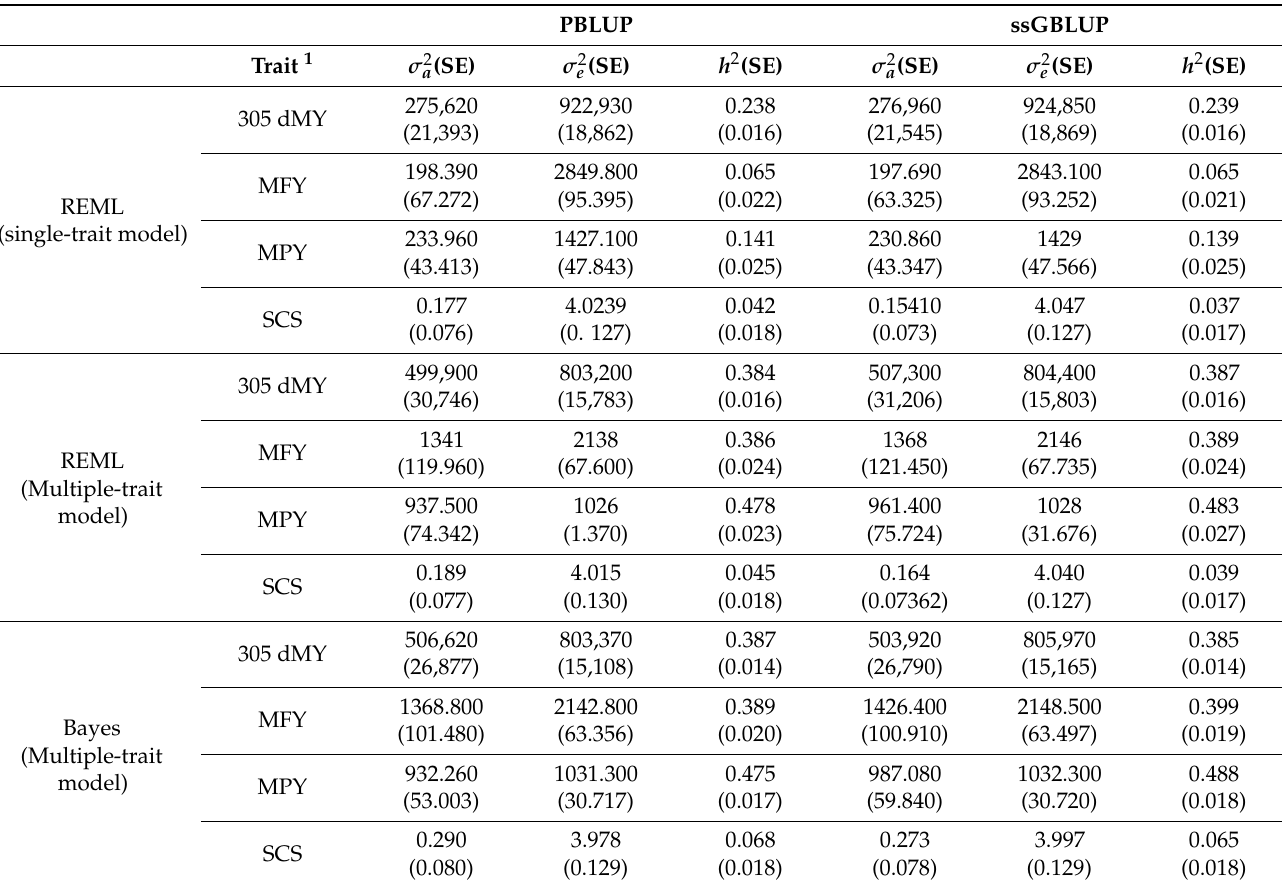
Table 2. Variance components and heritability of milk traits obtained using the pedigree relationship matrix (pedigree-based best linear unbiased prediction (PBLUP)) and combined genomic-pedigree matrix (single-step genomic best linear unbiased prediction (ssGBLUP)) (SE of variance components and heritability reported in parentheses).